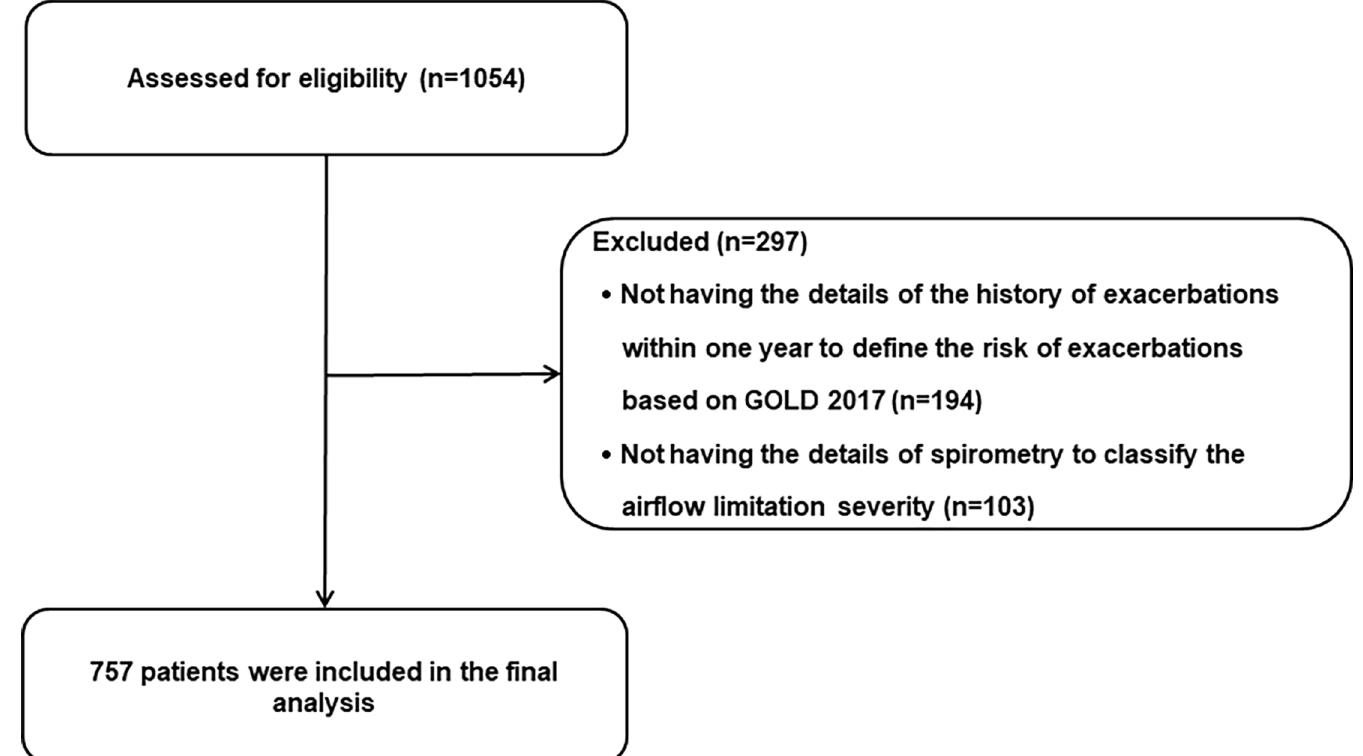
Fig 1. Patient enrollment flow chart. Abbreviations: GOLD, the Global initiative for Chronic Obstructive Lung Disease.